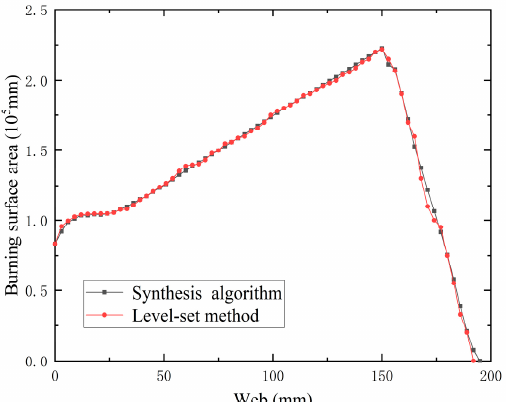
Figure 9. Comparison the burning surface area of the synthesis algorithm and LS algorithm in NAWC No. 6 partial grain.